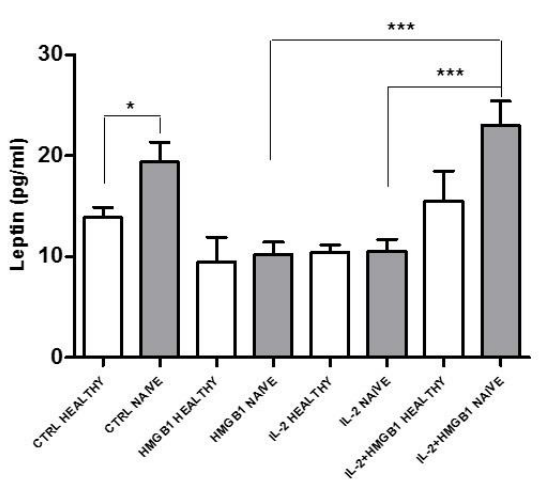
Figure 8. PBMCs were isolated from healthy donors and newly diagnosed T2DM patients (naïve). Isolated PBMCs have been washed twice, incubated with HMGB1 or IL-2 and IL-2 plus HMGB1 (PBMCs were incubated with IL-2 for 72 h and then treated with HMGB1 for the following 48 h). At the end of treatments, leptin secretion was evaluated on serum supernatants in both healthy and naïve PBMCs donors. IL-2/HMGB1 coupled treatment increased leptin secretion in naïve PBMCs compared to both IL-2 or HGMB1 single treatment, similar results were obtained in healthy donors’ PBMCs. The amount of leptin released by naïve PBMCs was found to be significantly increased compared to healthy PBMCs, especially in basal conditions. Data are expressed as mean ± SEM and were analyzed with Wilcoxon – Mann – Whitney U Test (* p < 0.05, *** p < 0.005, n = 5 each group).